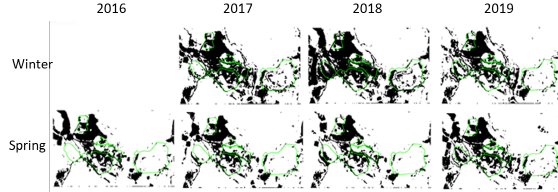
Figure 3. Annual evolution of the vegetation cover map in winter and